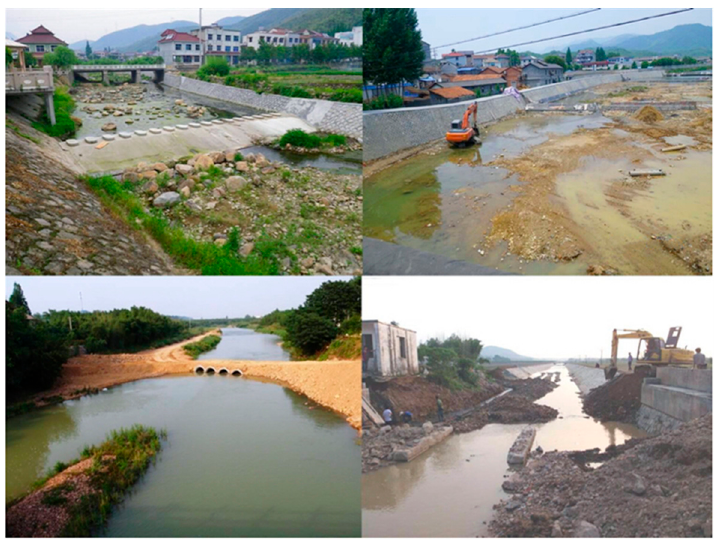
Figure 3. Threat to riverine fish biodiversity of Yangtze River posed by engineering construction.